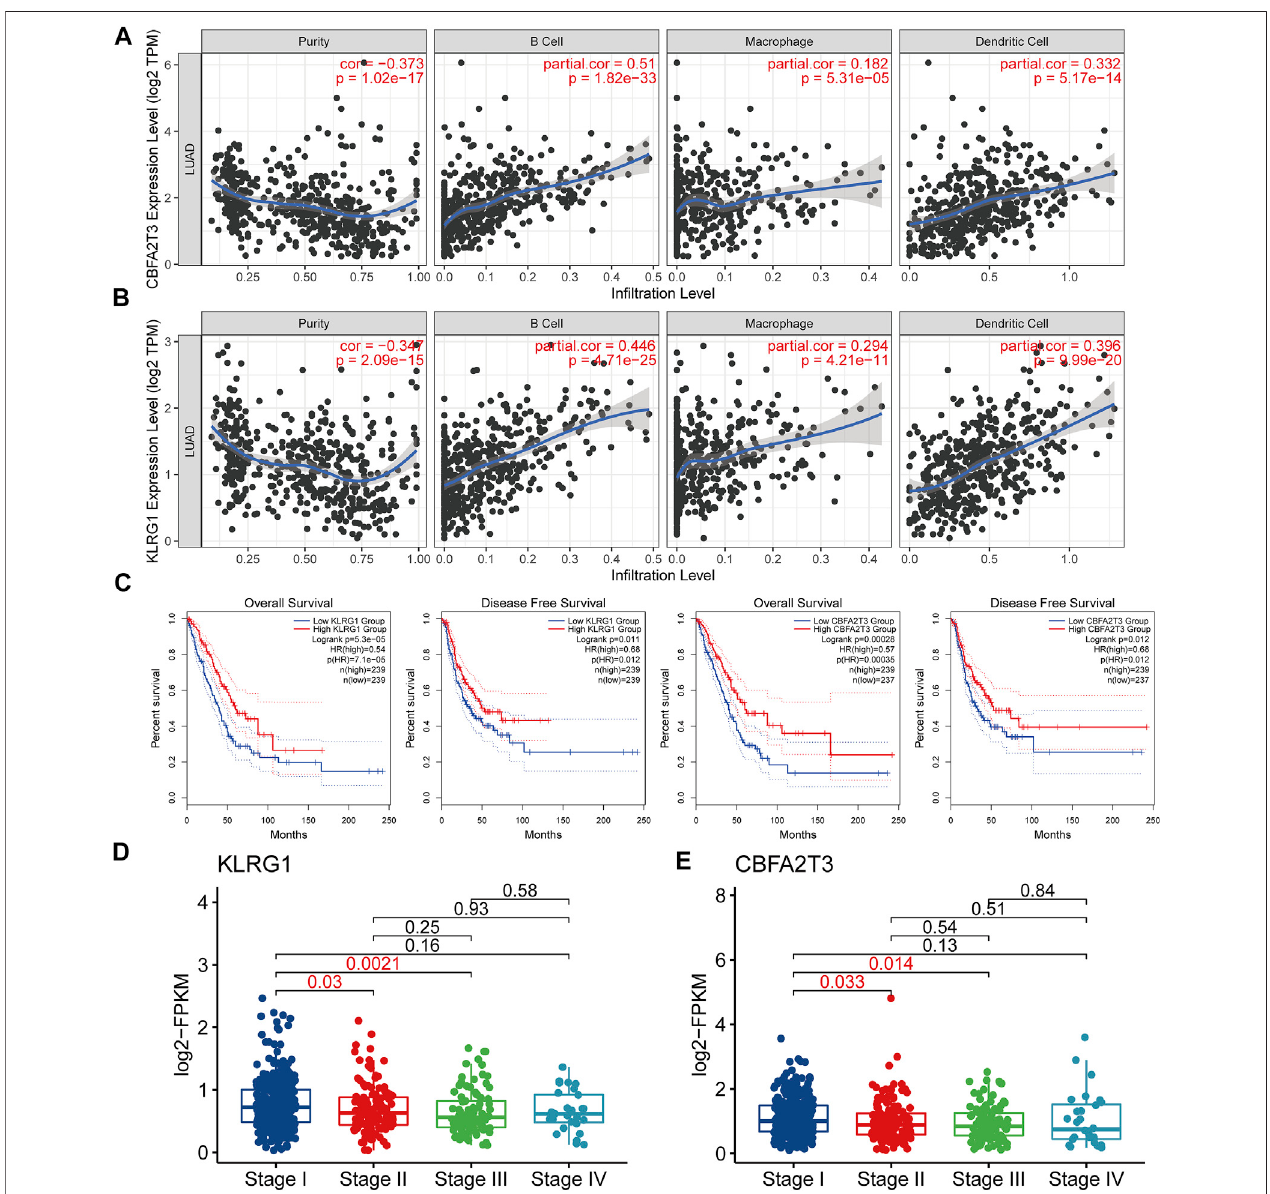
FIGURE 2 | Identi fi cation of tumor antigens in lung adenocarcinoma that can be used to develop mRNA vaccines (A) The expression of CBFA2T3 is positively correlated with the in fi ltration of a variety of antigen-presenting cells. (B) The expression of KLRG1 is positively correlated with the in fi ltration of a variety of antigen- presenting cells. (C) CBFA2T3 and KLRG1 are associated with overall survival and disease-free survival in patients with lung adenocarcinoma. (D – E) Expression of CBFA2T3 and KLRG1 in different stages of patients with lung adenocarcinoma.